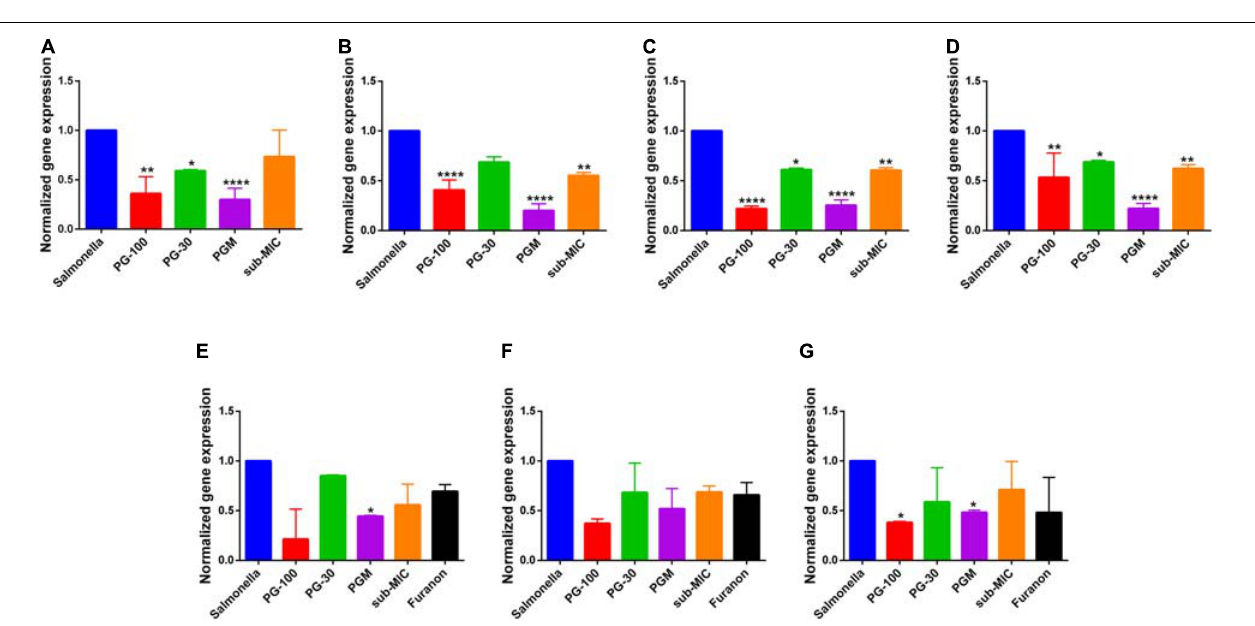
FIGURE 5 | Accumulation of fluoroquinolone by pyrogallol. (A) The graph showed the increase in the accumulation of ciprofloxacin by various concentration of pyrogallol using PA β N as a positive control. (B) Fluorescence microscopy showed increased accumulation of fluoroquinolone by pyrogallol (A, Ciprofloxacin; B, Ciprofloxacin with PG 30 µ g/mL; C, Ciprofloxacin with 100 µ g/mL pyrogallol; D, Ciprofloxacin with 40 µ g/mL of PA β N). NC – bacteria exposed to ciprofloxacin only; CPG-30 – bacteria exposed to ciprofloxacin and 30 µ g/mL of pyrogallol; CPG-100 – bacteria exposed to ciprofloxacin and 100 µ g/mL of pyrogallol; PA β N – bacteria exposed to ciprofloxacin and 40 µ g/mL of PA β N. * p < 0.05 and *** p < 0.001.